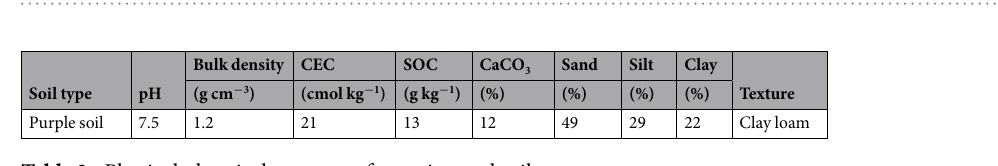
Table 3. Physical-chemical property of experimental